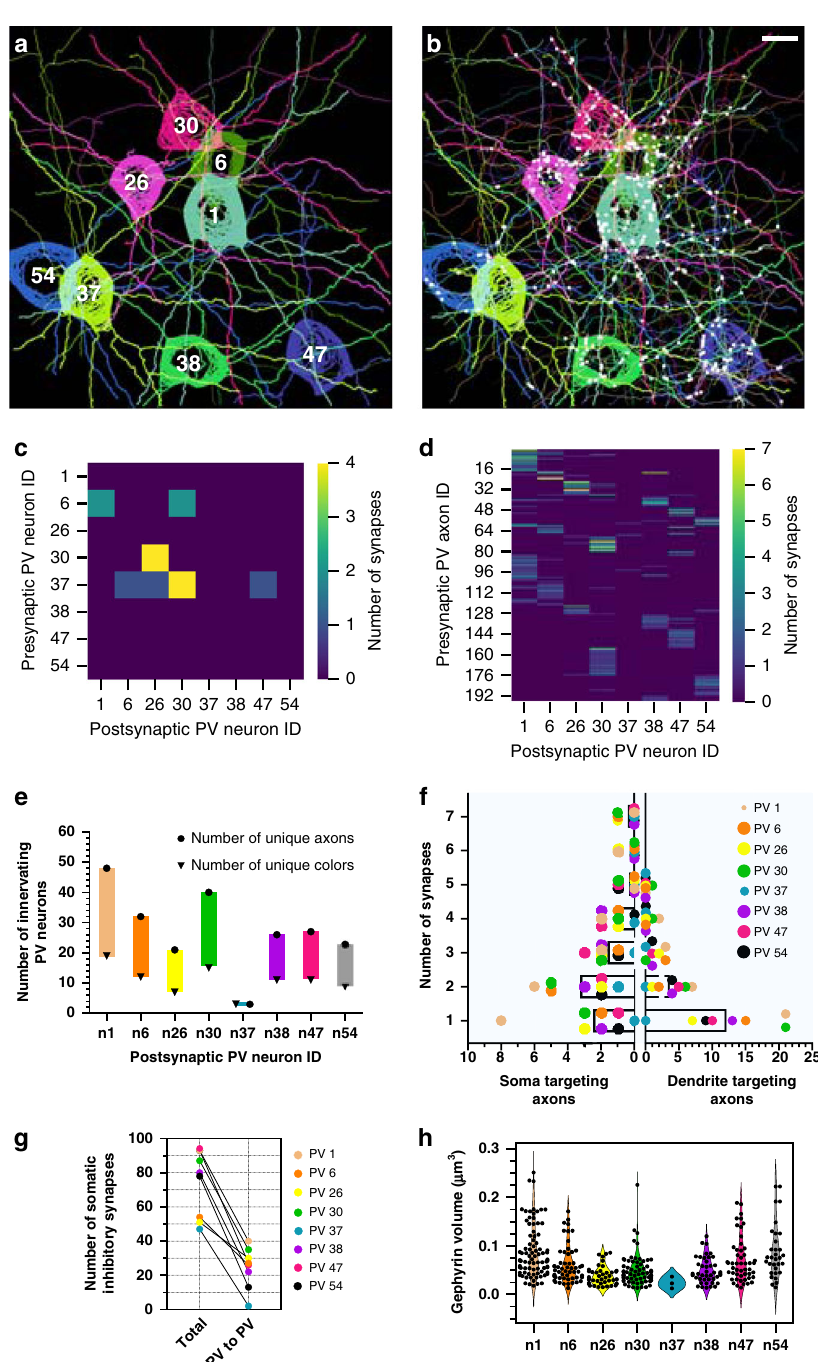
Fig. 4 Molecularly speci fi c analyses can be performed on spectral connectomics data. a Eight Brainbow labeled PV neurons reconstructed with nTracer. Thick neurites represent dendrites; thin neurites represent axons. The neuron IDs are overlaid. b Same as a , plus all of the other 189 innervating axons overlaid and 422 identi fi ed synapses marked with white circles. c Connectivity matrix between the eight reconstructed PV neurons. d Connectivity matrix as in c , plus the 189 innervating axons. e Plot of the maximum and minimum number of unique presynaptic PV neurons that innervate each of the eight postsynaptic PV neurons. Circles represent the number of spatially distinct PV axons that formed synapses, while triangles represent the number of unique colors that could be identi fi ed from the innervating axons. f Distribution of the number of soma targeting and dendrite targeting axons as a function of the number of synapses they form. Each of the eight afferent PV neurons are color coded and plotted with the average represented by the bar graph. g Total number of somatic inhibitory synapses were plotted relative to the PV to PV subset for each of the eight postsynaptic PV neurons. h Inhibitory PSD (Gephyrin) size plotted for all the PV to PV synapses found on each of the eight postsynaptic PV neurons. Scale bars: 10 μ m (pre-expansion